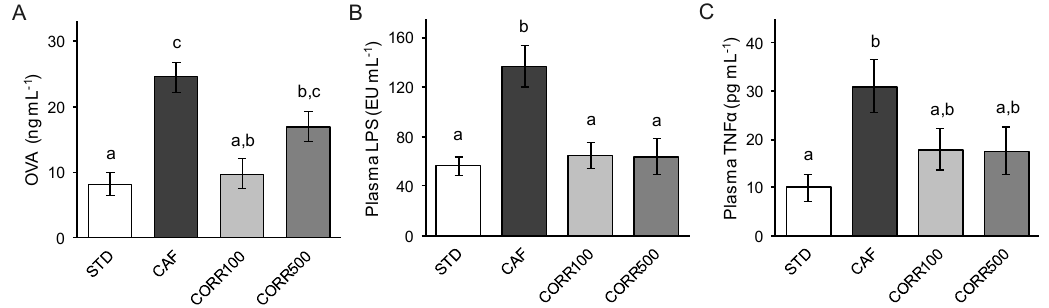
Figure 2. The effect of the grape-seed proanthocyanidin extract (GSPE) treatment on intestinal permeability, metabolic endotoxemia and systemic inflammation in diet-induced obese rats. Values represent mean ± SEM; n = 8–10. Different letters indicate the statistically significant differences between groups ( p < 0.05); ANOVA test followed by Tukey’s HSD test when variances were equal and Dunnett’s T3 test when they were not.